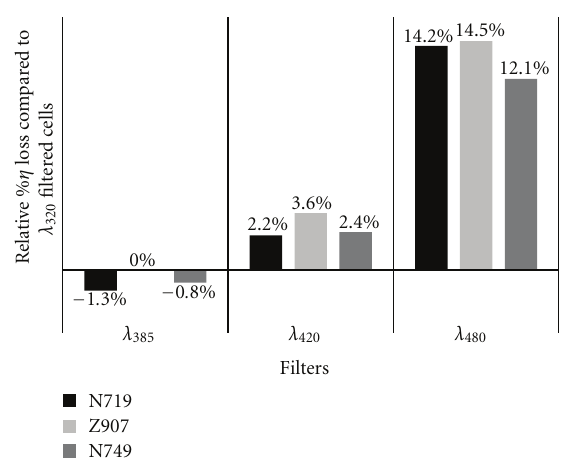
Figure 9: E ffi ciency losses in reverse illuminated cells caused by the filters shown and compared to cells filtered with the λ 320